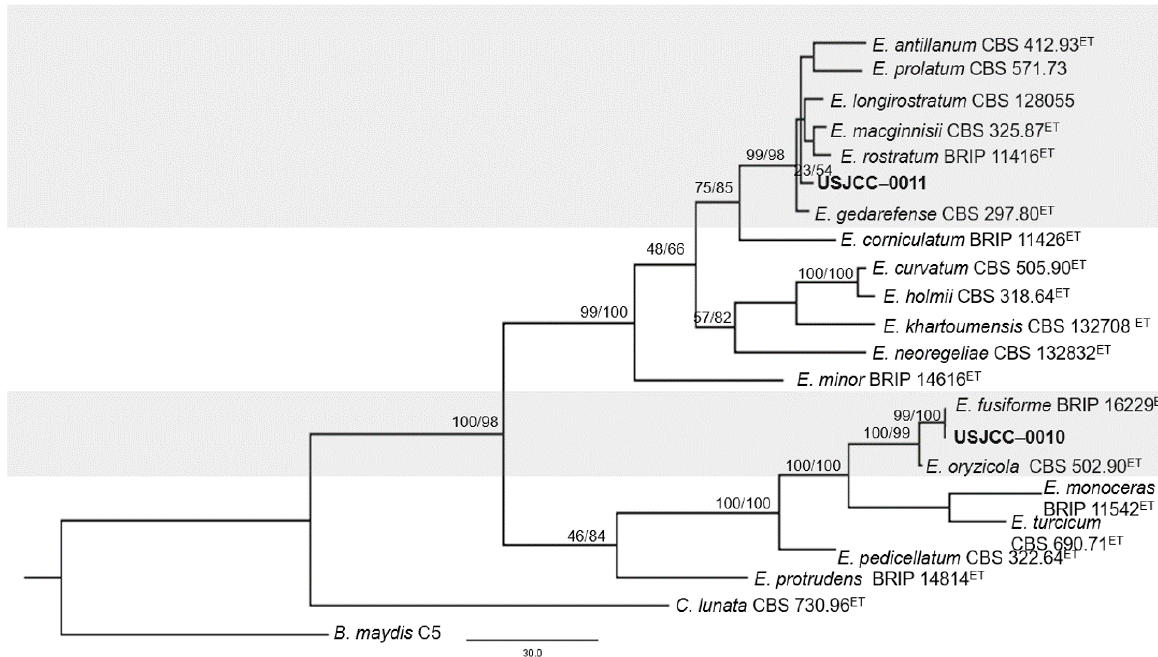
Figure 1: A Maximum Parsimony phylogenetic tree generated based on the combined ITS, GPDH and TEF1-α sequence alignment. MP/ML bootstrap support values are indicated on the branches respectively. Fresh collections from the current study are in bold. The tree is rooted with Bipolaris maydis . ET: